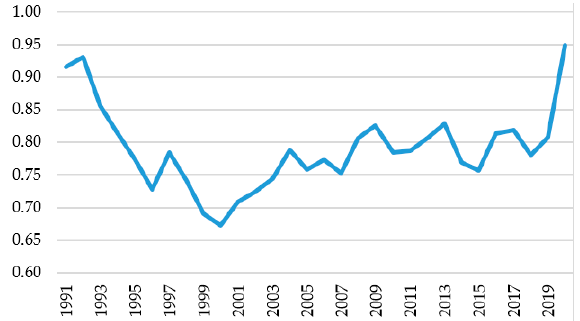
Figure 10. Index of economic security for Ukraine.